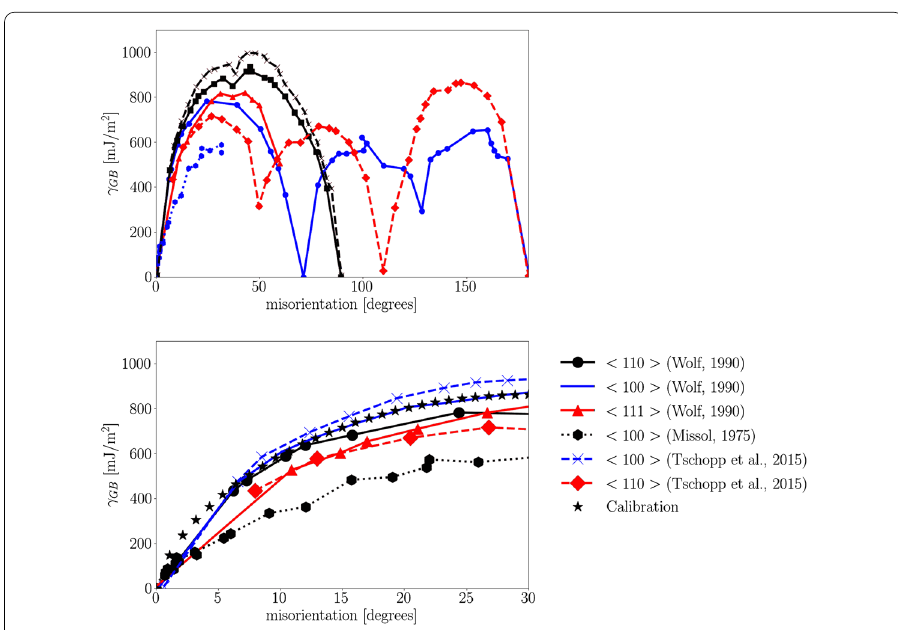
Fig. 1 Top: grain boundary energy as a function of misorientation for copper, obtained from atomistic calculations [50–52]. Bottom: result from calibration of model parameters for the orientation phase-field model (black stars) to fit the calculated grain boundary energy of a < 100 > tilt grain boundary from [50] (solid blue line). Only angles up to 30 ◦ are considered in the calibration because the model does not